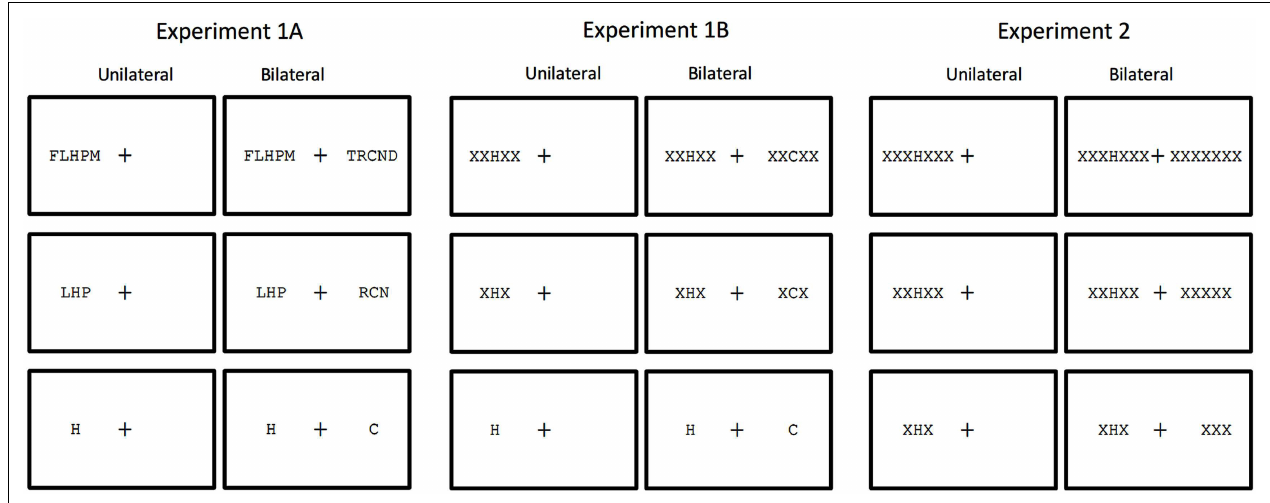
Experiments 1A and 2 are Xs. Note that the conditions tested in Experiment 2 are the same as Experiment 1B, except that all stimuli in the contralateral field of the bilateral condition are Xs, and with the zero-flanker condition replaced by a six-flanker